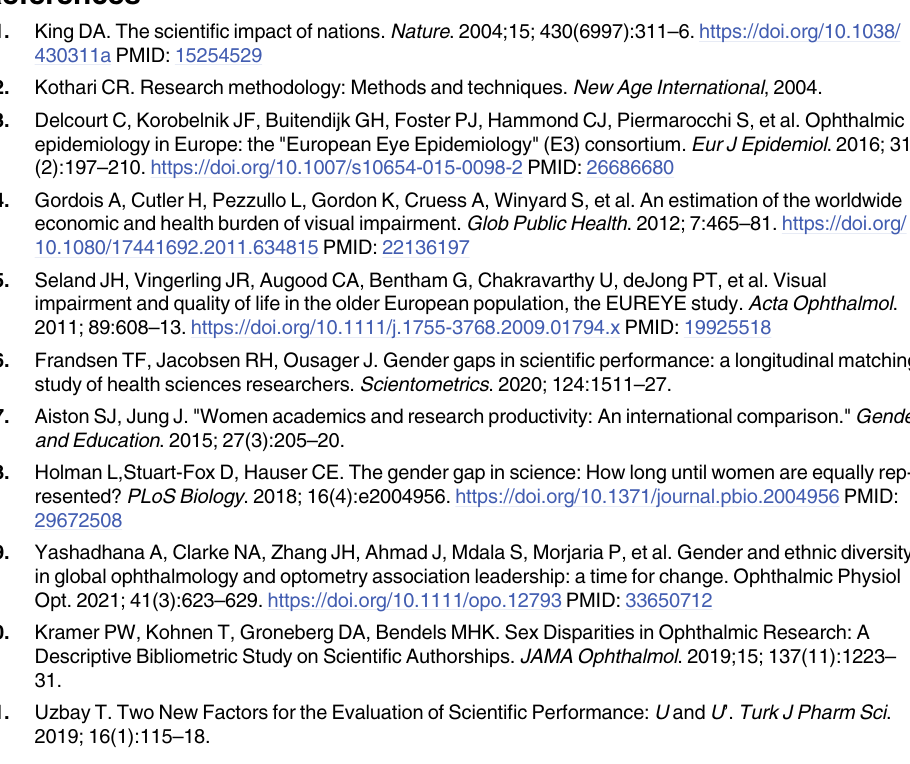
S1 Table. The Turkish version of the survey. S2 Table. The English version of the